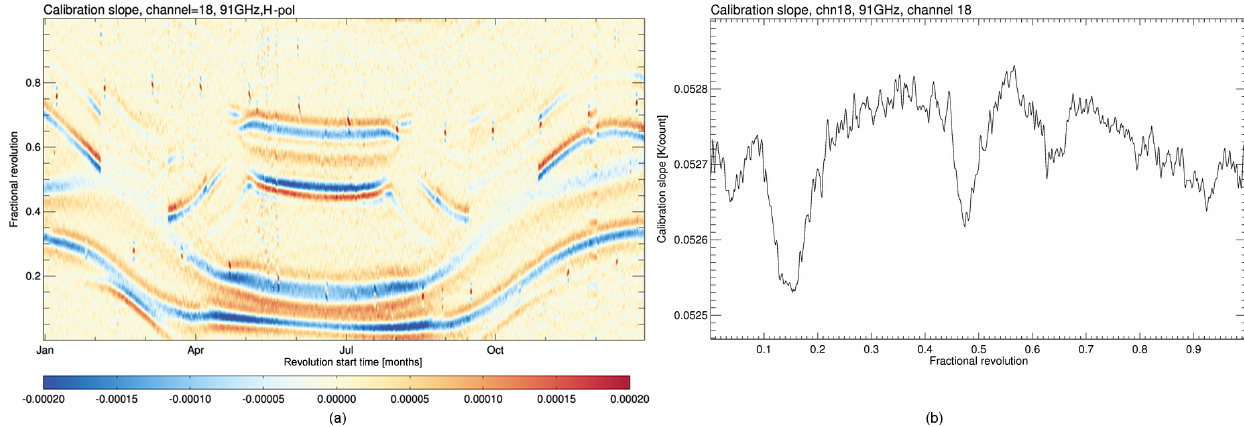
Figure 6. Edge detection results (Laplace operator) for calculated first-guess slopes from the SSMIS F16 channel at 91GHz, h-pol for 2010 (a) and a cross section of first-guess slope (b) for one orbit in June 2010 (right). Four regions with warm load intrusion are identified around orbit positions 0.04, 0.15, 0.48, and